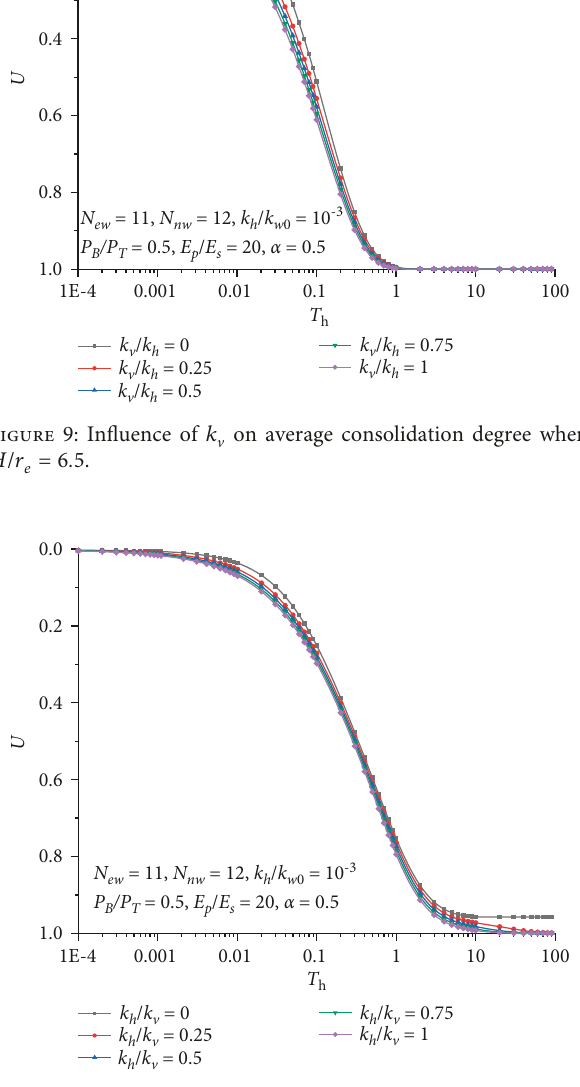
Figure 8: Effect of impervious pile replacement rate on foundation consolidation.